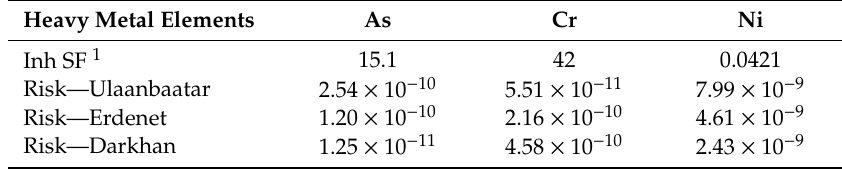
Table 8. Carcinogenic risks for metal elements in soil collected from major cities in